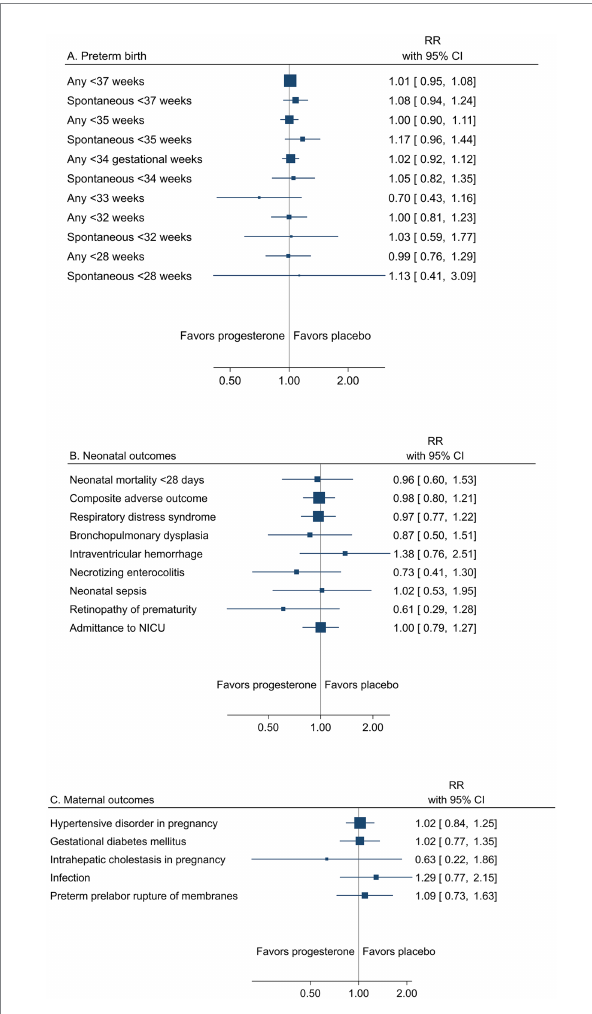
FIGURE 5 Summary graph of pooled estimates from meta-analyses comparing progesterone and placebo in women with a multifetal pregnancy with or without additional risk factor(s) for preterm birth, from trials with low risk of bias regarding (A) preterm birth, (B) neonatal, and (C) maternal